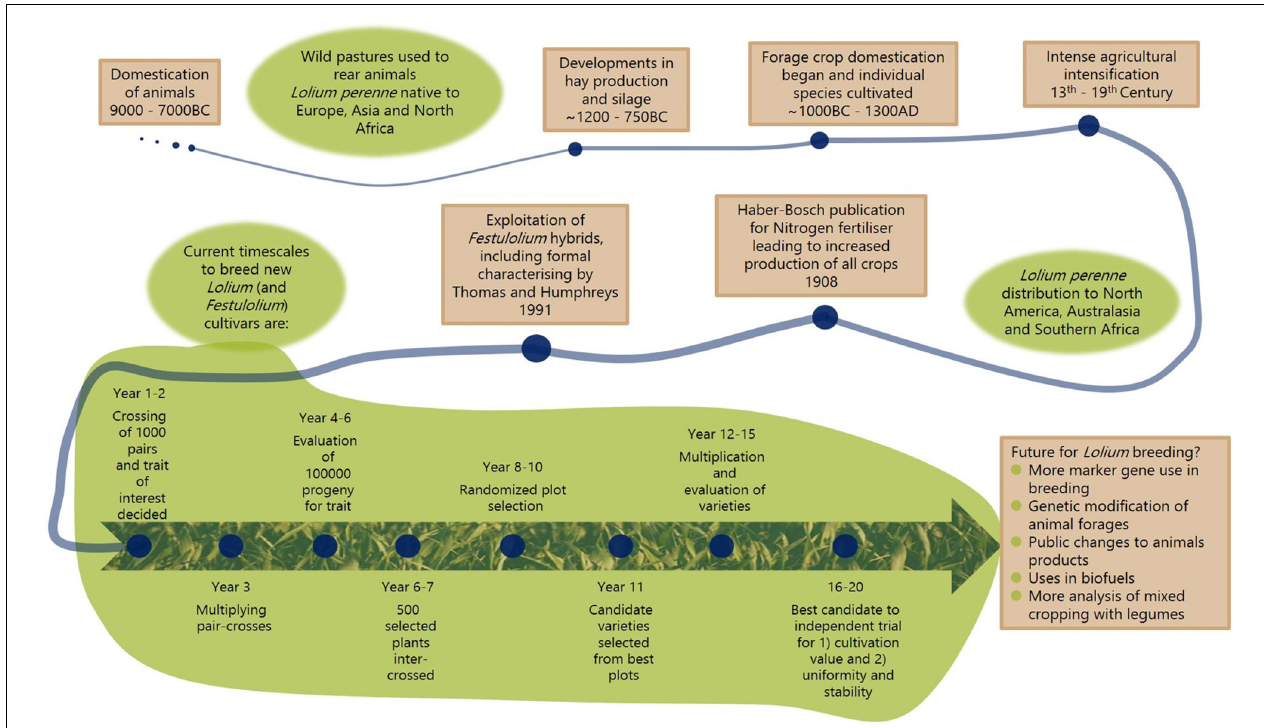
FIGURE 2 | Cultivation timeline of Lolium perenne (perennial ryegrass), including current typical breeding regime and future possibilities for breeding programs. The historical timeline is described in brown boxes (Haber, 2002; Hirata, 2011), and general trends in green areas, including modern grass breeding regime as used across Europe (Bruins,